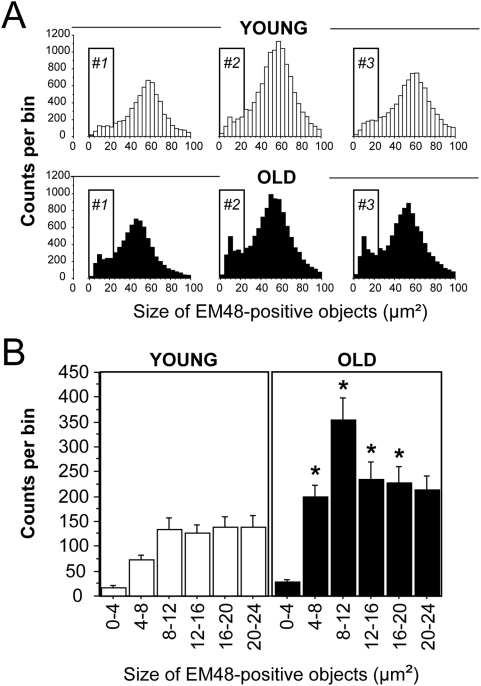
Morphometric analysis of EM48-positive inclusions/aggregates shows age-dependent differences.Young (3 week) and old (15 month) rats received a stereotaxic injection of lentiviral vectors encoding Htt171-82Q (2 µl, 200 ng/µl of p24) into the striatum. Histological evaluation was carried out 4 weeks after infection using EM48 immunohistochemistry and image analysis software. The number of EM48 positive objects was computed for 25 bins (steps of 4 µm2) based on cross-sectional area. A, typical individual distribution of object size is shown for 3 young rats (#1 to #3) and 3 old rats (#1 to #3). Note that the proportion of small aggregates (grey vertical bar) is higher in old animals than in young rats. B, the averaged distribution of small aggregates is shown for the two experimental groups (n = 6 per group). Note the clear cut augmentation of the number of aggregates with an apparent cross-sectional area in the 4–20 µm2 range in older rats. Note also that the distribution peak of EM48 positive objects in the 40–60 µm2 range was shifted to the left in older rats (∼46 µm2) as compared to young animals (∼58 µm2). A similar shift was found in all animals, consistent with a decreased nuclear inclusion size. Results are expressed as mean+/−SEM. *p<0.05, ANOVA and Bonferroni's post hoc test.